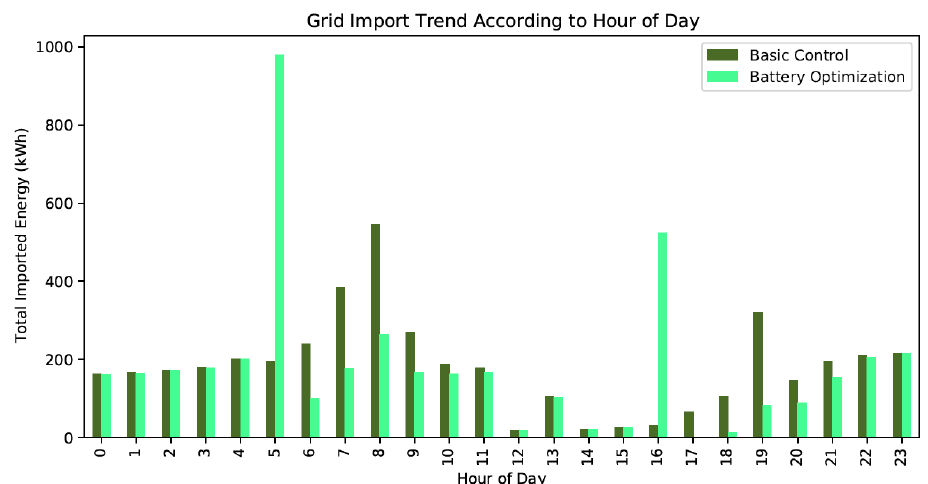
Figure 12. Grid import distribution between EMS methodologies.